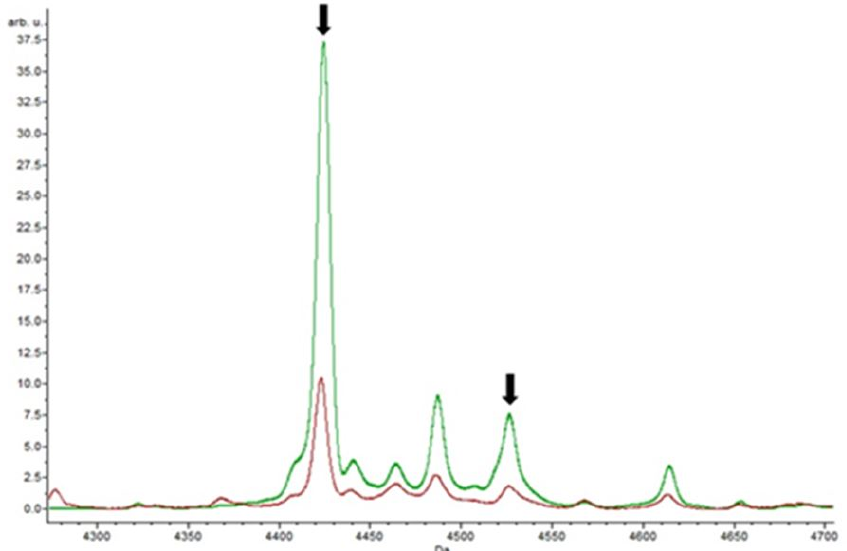
Figure 3. Peaks obtained for tetracycline. From the analysis of the ClinProTools software, the control spectrum without antibiotics (red) and the spectrum with the action of tetracycline (green) were obtained. The results show statistically significant peaks, with a p -value of 0.0000001, such as masses m / z 4424.01 and m / z 4526.45 noted by